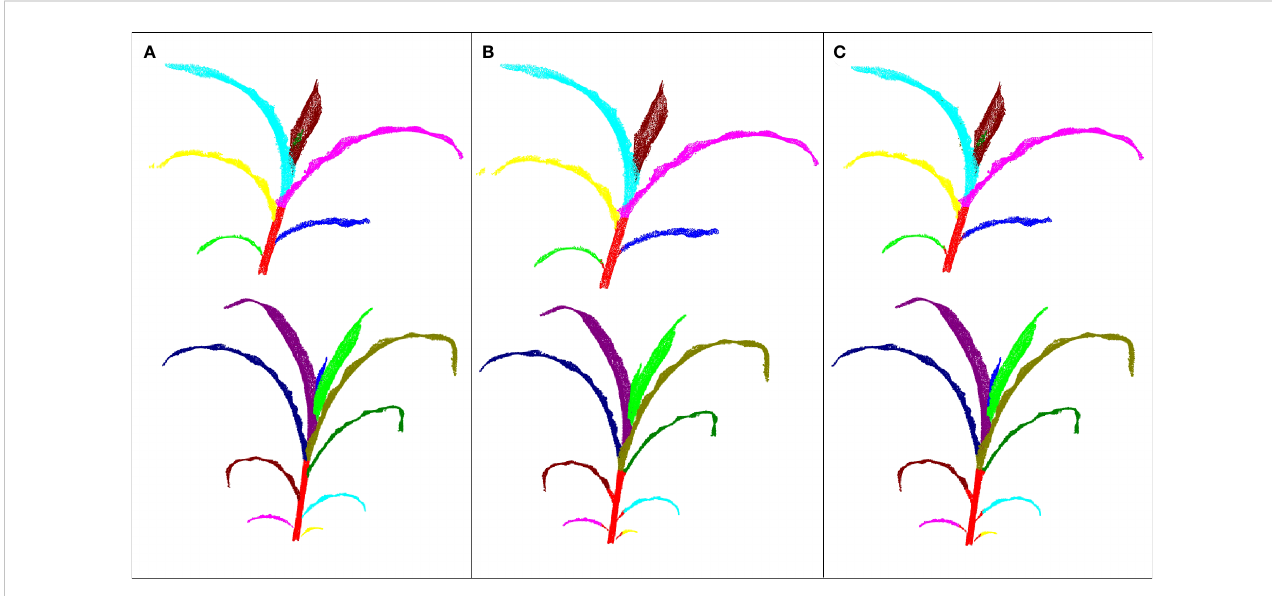
FIGURE 8 The new leaf segmentation results. (A) Ground truth; (B) K 2 set at 32; (C) . K 2 set at